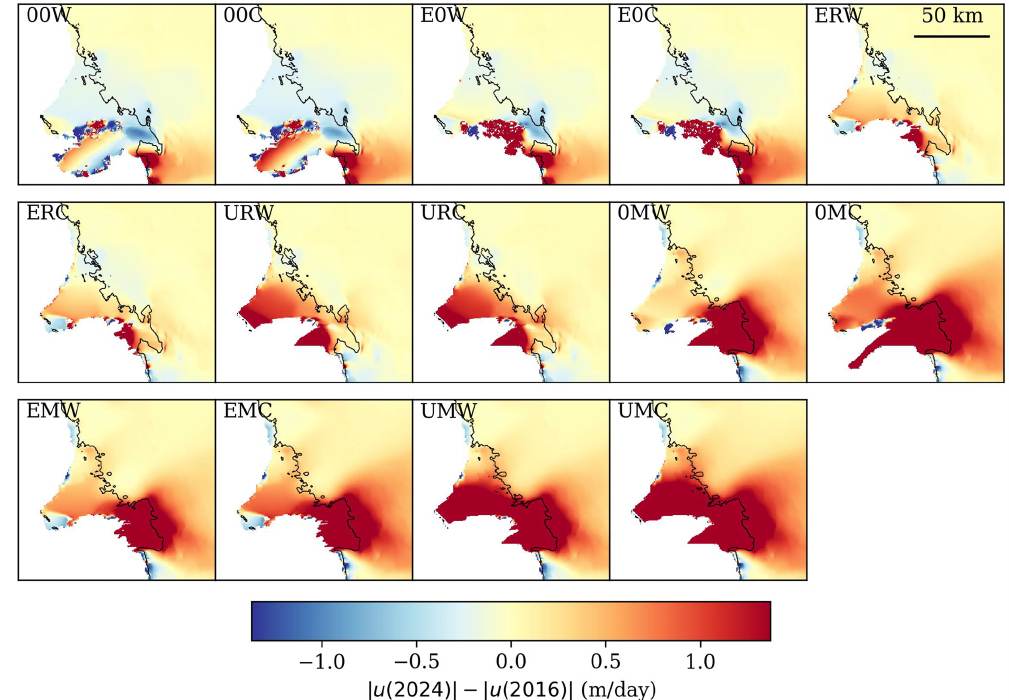
Figure A1. As Fig. 11, except showing differences in velocity between 2016 and 2024.